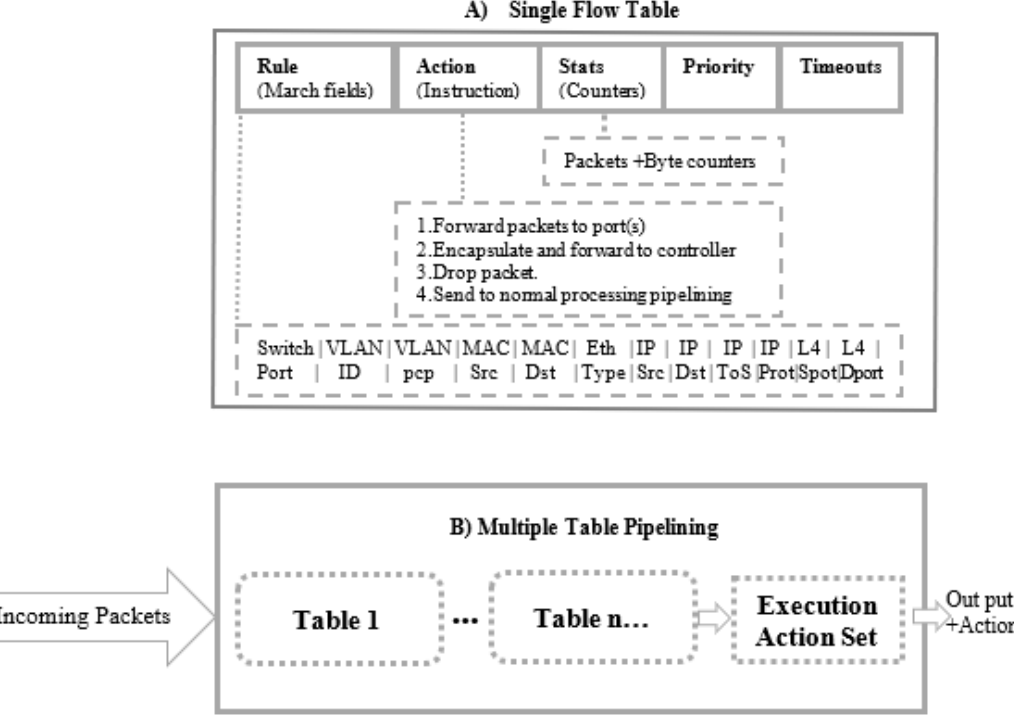
Figure 2. Single vs. multiple flow table. ( A ) Single Flow Table and ( B ) Multiple Flow Table respectively.